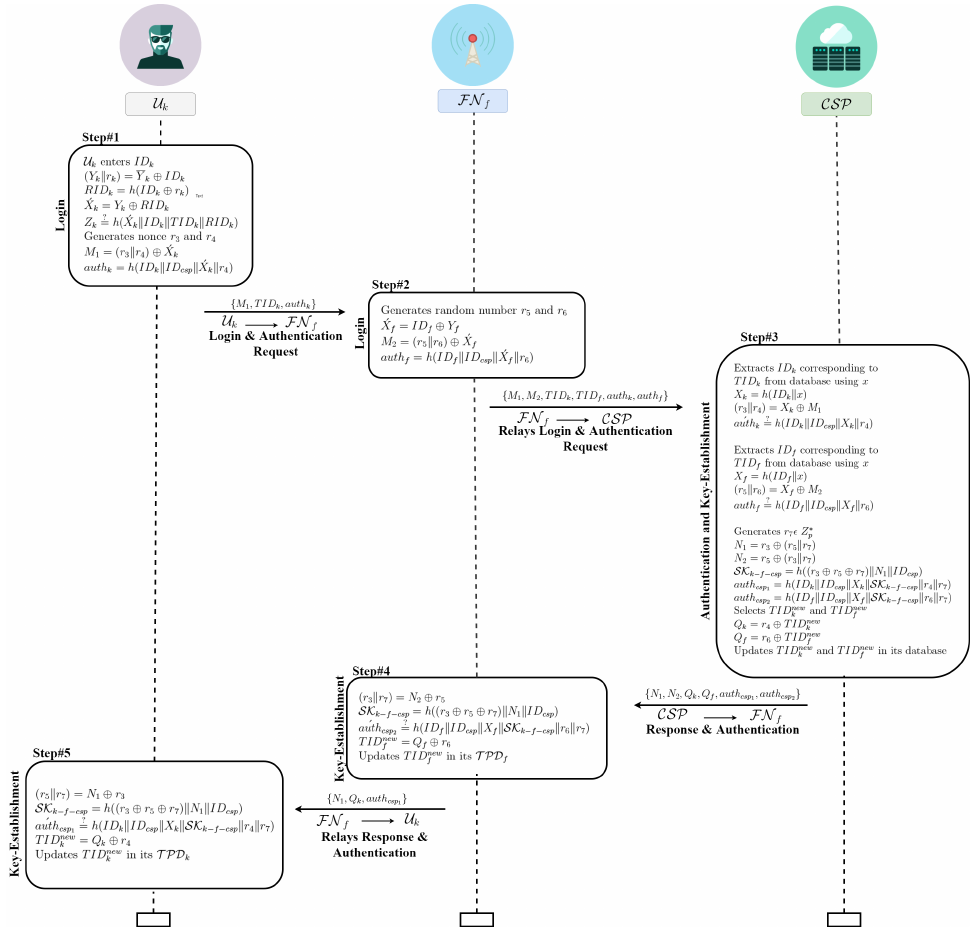
Figure 3. Login and authentication